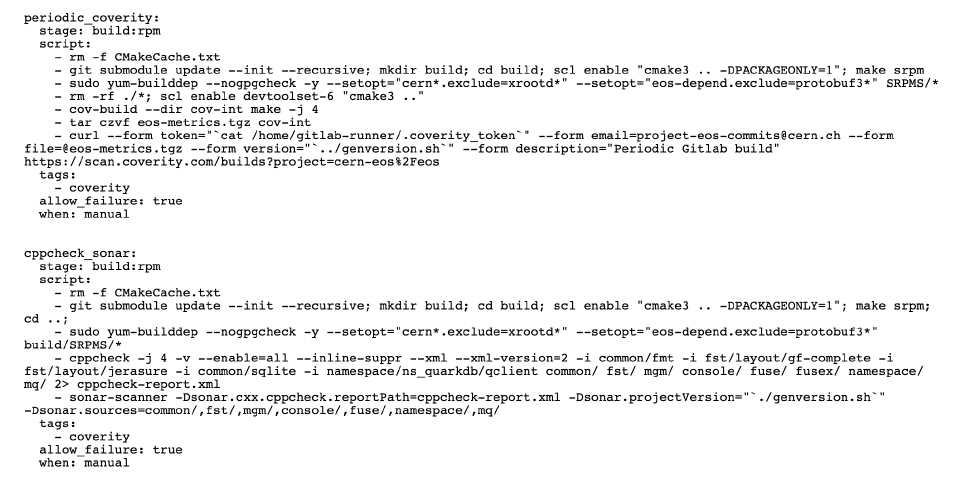
Figure 2. EOS Coverity details